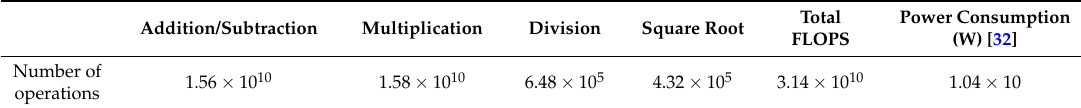
Table 1. Floating point operations per second